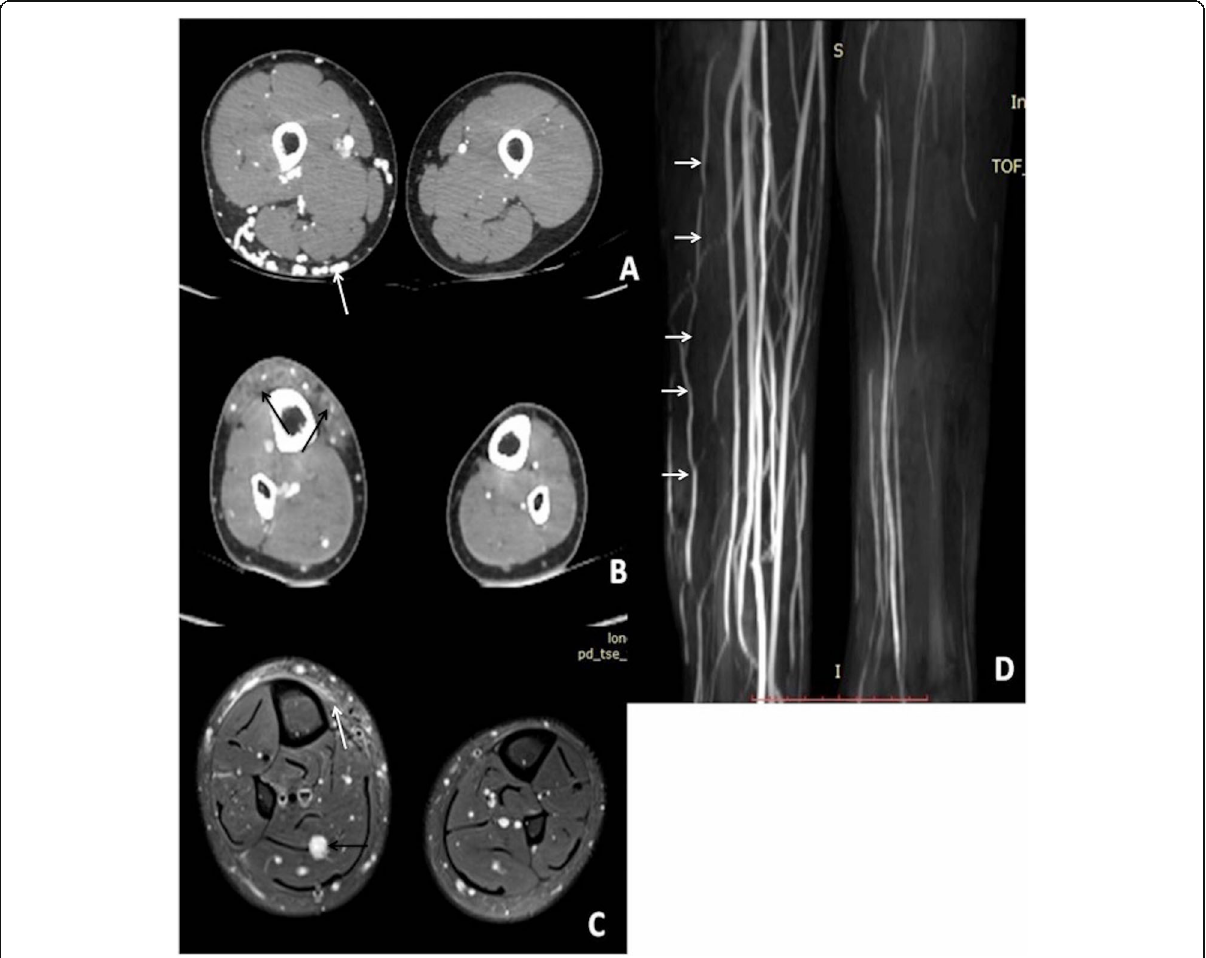
Fig. 5 Axial contrast-enhanced CT showing hypertrophied right thigh with multiple subcutaneous varices (white arrow in a ) and well defined subcutaneous capillary malformation in anterior aspect of right leg (black arrow in b ). Axial proton density MR image ( c ) showing hypertrophied right leg with subcutaneous capillary malformations (white arrow in c ) and intramuscular varices (black arrow in c ). MIP TOF 2D MR venogram image ( d ) showing lateral marginal vein of Servelle (red arrow), multiple varicosities, and normal deep venous system of the right lower